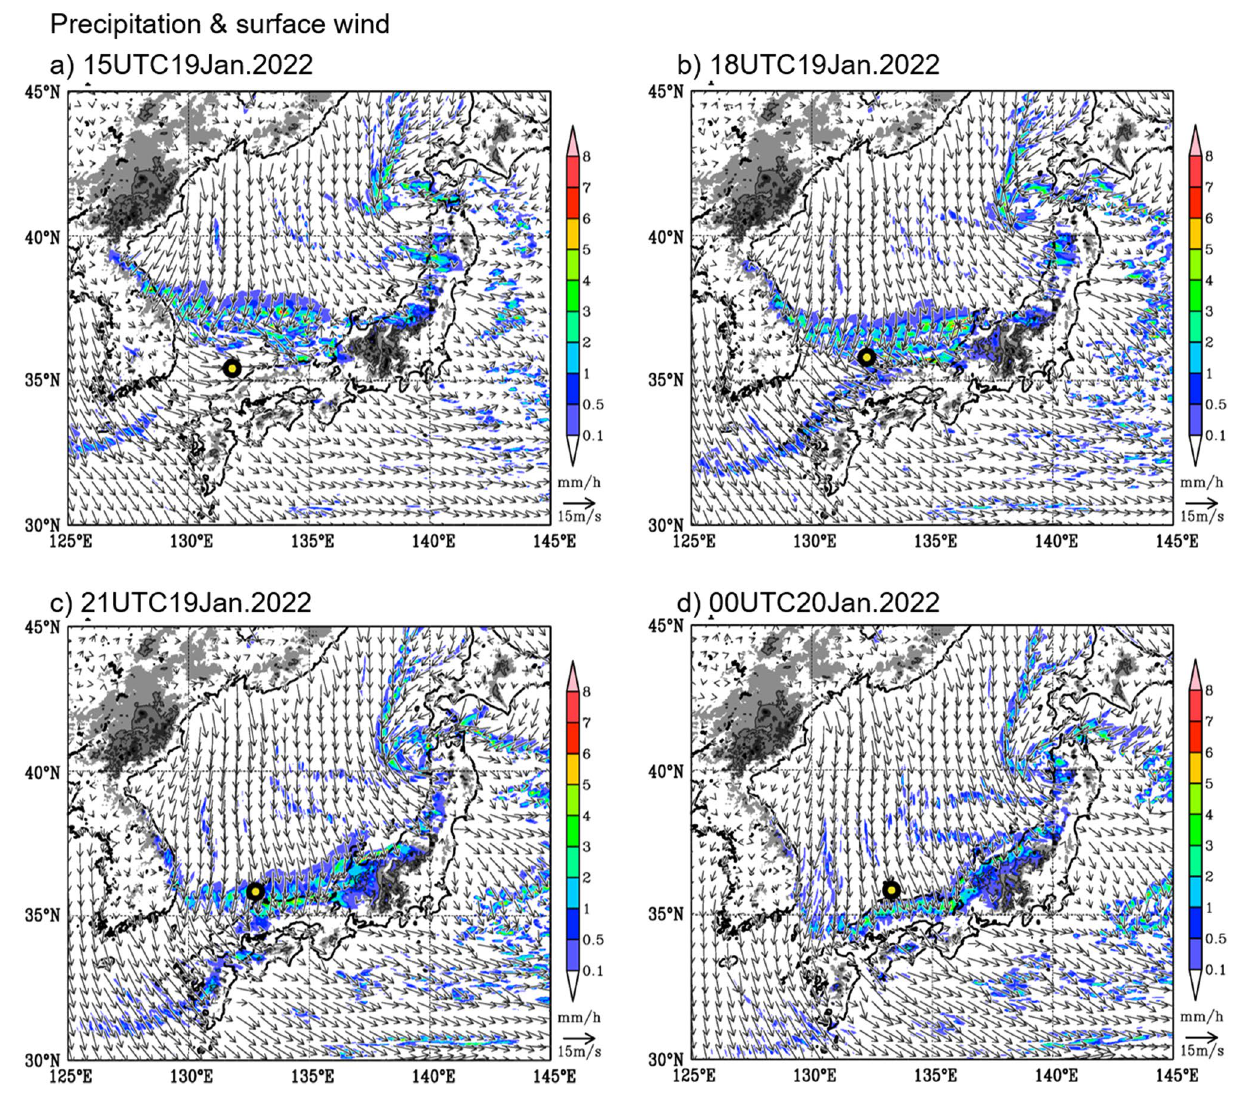
Figure 7. JPCZ by a numerical simulation during the observation period. Surface wind and precipitation simulated by the nonhydrostatic numerical model (NHM) of JMA at the same time as the onboard observation. Initial date is 00UTC 18 January 2022. ( a ) 15UTC 19 January. A heavy circle indicates the ship location at the time of the model results. ( b ) 18UTC 19 January, ( c ) 21UTC 19 January, and ( d ) 00UTC 20 January. Precipitation is indicated in mm/h. Grey shadings represent topography over 500 m and get dark every 500 m. The surface wind is drawn over 500 m. Contours show the elevation of 1000